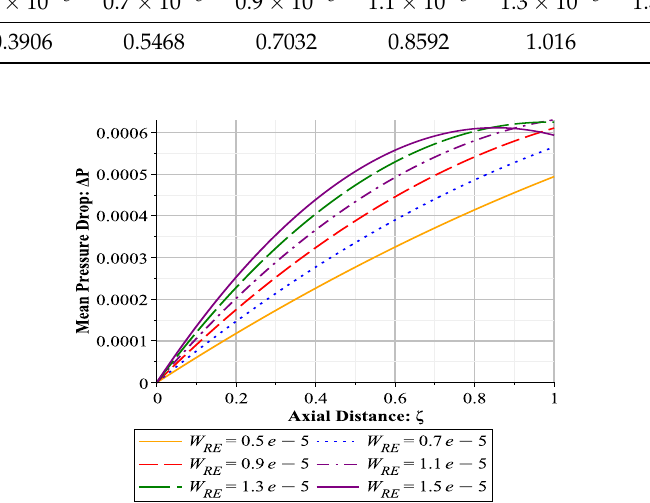
Table 2. Variation in fractional reabsorption FR with wall Reynolds number W RE for N RE = 3.2 × 10 − 2 . W RE